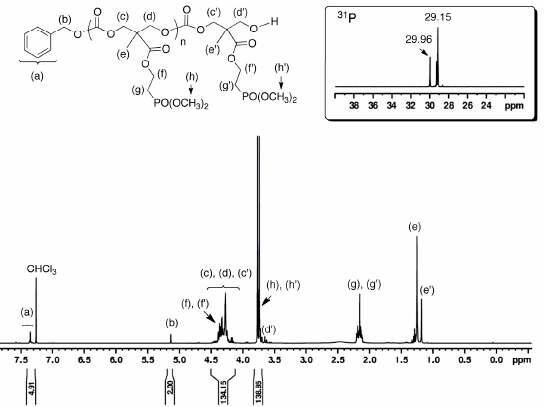
Figure 2. Overlaid 1 H ( bottom ) and 31 P NMR ( top right corner ) spectra of the phosphonate-functionalized polycarbonate 5 with DP n,NMR = 23 and Ð = 1.22. Table 1. Summary of ROP of 4 and its copolymerization with MPC monomer using TU/DBU.